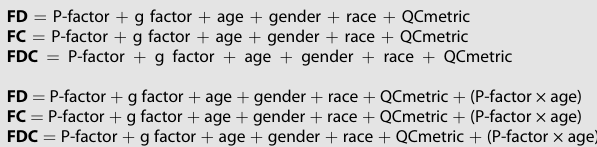
Box 1. The models examining fi xel-based (FD, FC, and FDC) correlates of P-factor scores, with all covariates FD = P-factor + g factor + age + gender + race + QCmetric FC = P-factor + g factor + age + gender + race + QCmetric FDC = P-factor + g factor + age + gender + race + QCmetric FD = P-factor + g factor + age + gender + race + QCmetric + (P-factor × age) FC = P-factor + g factor + age + gender + race + QCmetric + (P-factor × age) FDC = P-factor + g factor + age + gender + race + QCmetric + (P-factor ×